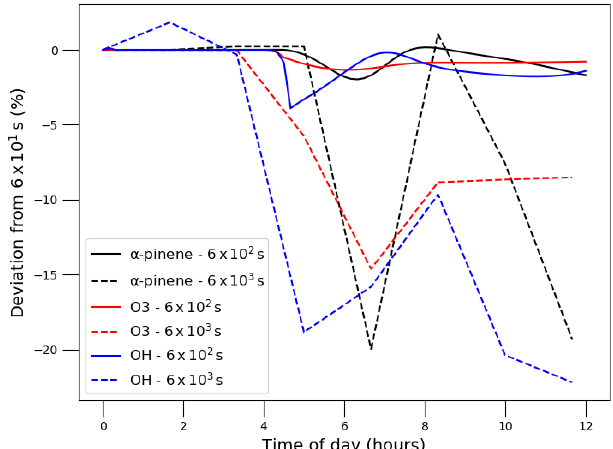
Figure 5. Illustrating the effect of update time interval resolution in PyCHAM on gas-phase concentrations of α -pinene, O 3 and OH for the experiment described above in Fig. 3 with α -pinene ozonolysis in the presence of NO x . Time intervals were set to 6 × 10 2 and 6 × 10 3 s as shown in the legend, and the deviation is from results for a time interval of 6 × 10 1